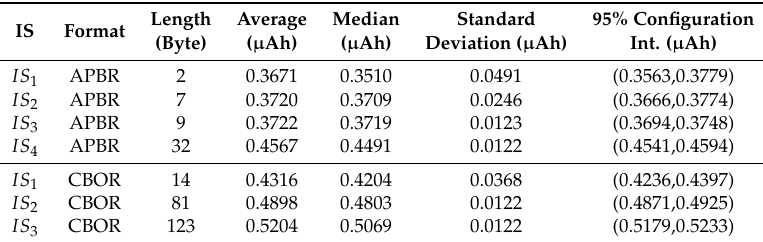
Table 11. Energy consumption